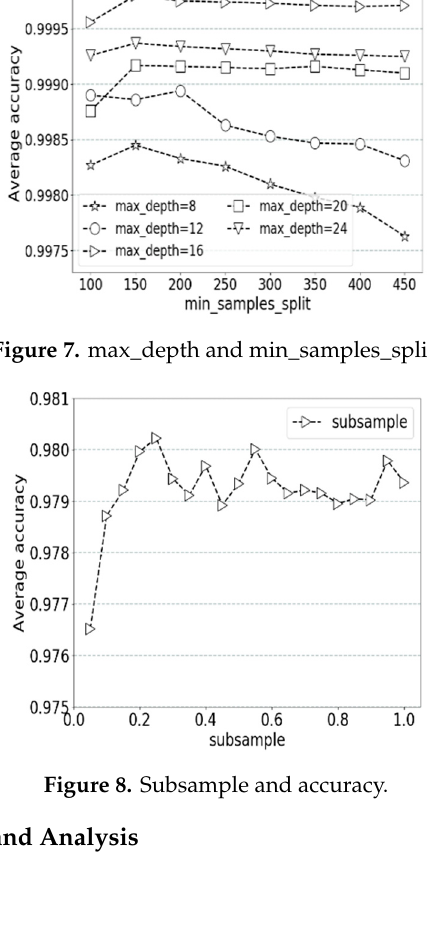
Figure 6. n_estimators and accuracy.